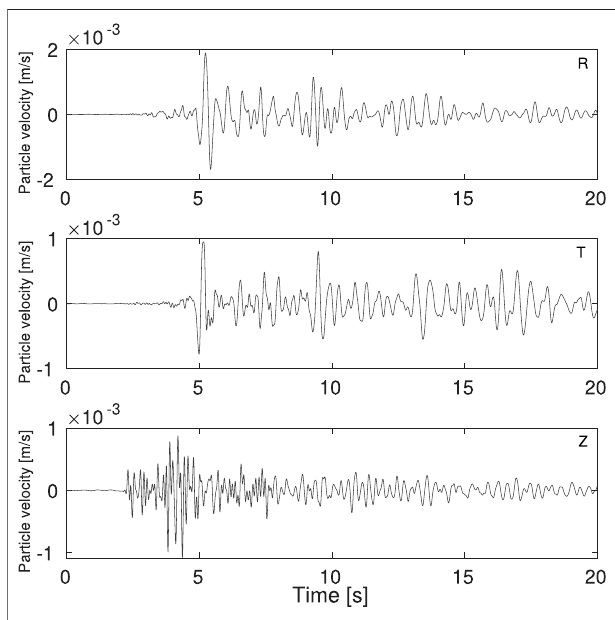
FIGURE 3 | 3-component seismogram recorded at the surface station of borehole G62 for the 08 – 01 – 2018 M3.4 Zeerijp earthquake. R = radial/east component, T = transverse/north component, Z = vertical